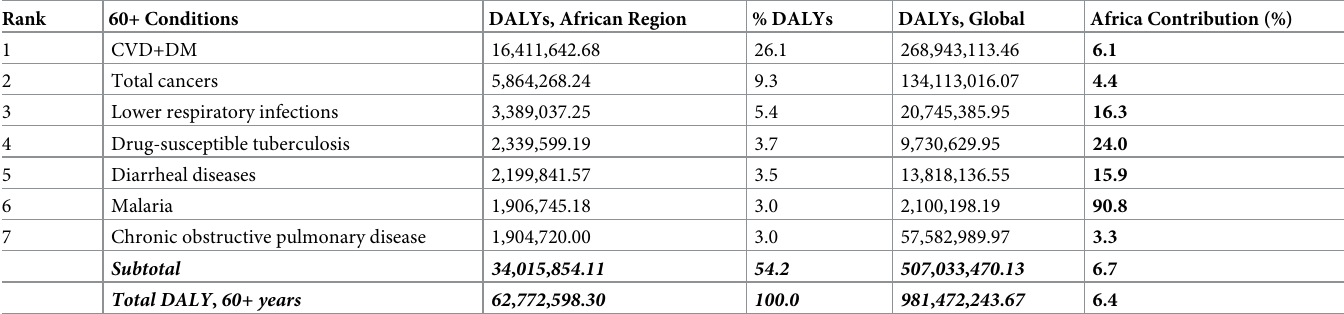
Table 8. Leading conditions in 60+ age cohort in the Africa region, global and African region DALYs contribution,